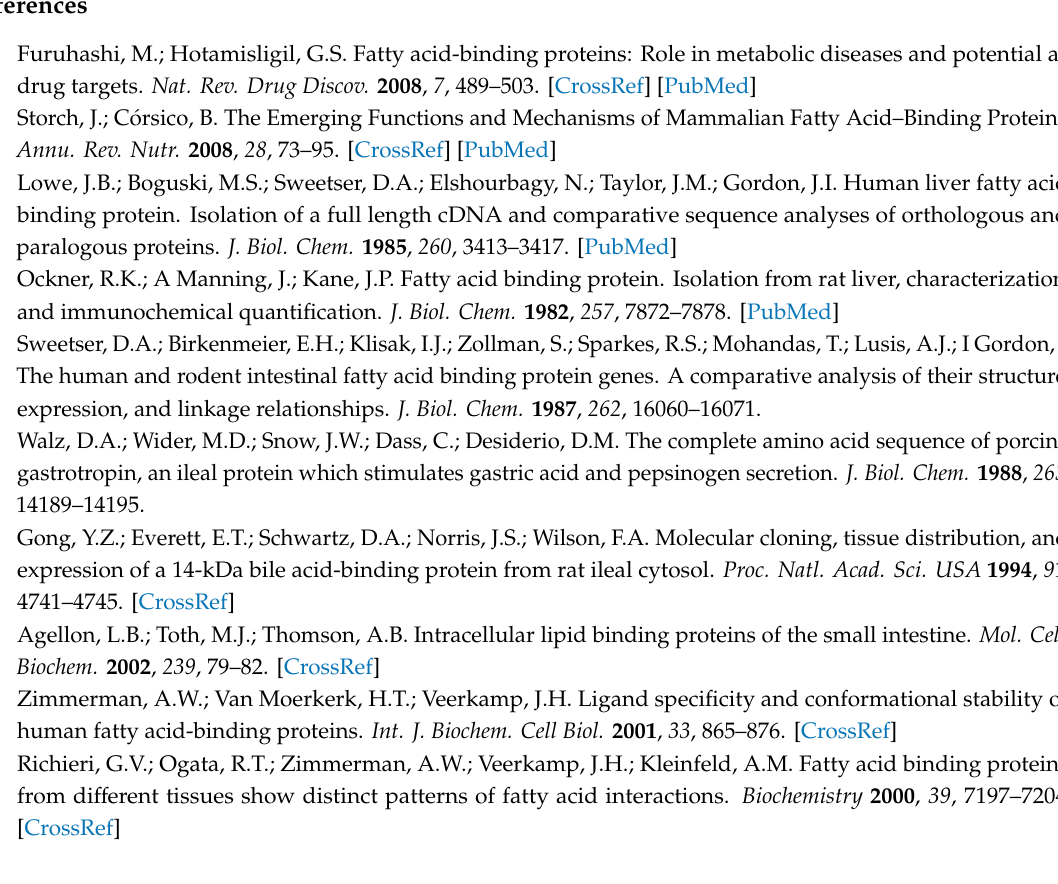
Supplementary Figure S1: Flowchart illustrating the microarray data analysis workflow. Supplementary Figure S2: Assessmentofthequalityofdatabycomparingsignalintensityfromthebiologicalreplicatesusinglinearcorrelation (x axis, replicate 1 and y axis, replicate (2) after robust multichip average (RMA) processing. Supplementary Figure S3: Assessment of the quality of the data by comparing signal intensities of shared probes on Chip 430A (x axis) and Chip 430B (y axis) for each biological replicate using the linear correlation after a robust multichip average (RMA) processing. Supplementary Figure S4: Assessment of the quality of microarray data using boxplot after robust multichip average processing. Supplementary Figure S5. The volcano plots of di ff erentially expressed genes in di ff erent Fabp gene-disrupted male and female mice. Supplementary Figure S6: Chromosomal location of sex-biased genes identified in wild-type (WT) and Fabp gene-disrupted mice. Supplementary Figure S7: Venn diagrams and heatmaps showing the number of di ff erentially expressed genes in male and female intestinal transcriptomes of di ff erent Fabp gene-disrupted genotypes. Supplementary Figure S8: Chromosomal location of di ff erentially expressed (DE) genes identified in male and female intestinal transcriptomes of di ff erent Fabp gene-disrupted genotypes. Supplementary Table S1: Complete lists of sex-biased genes and di ff erentially expressed (DE) genes. Supplementary Table S2: List of the biological processes cited in Figure 3 categorized under lipid metabolism, carbohydrate metabolism, protein metabolism and sterol metabolism. Supplementary Table S3: List of nodes, edges and seeds identified in the networks shown in Figure